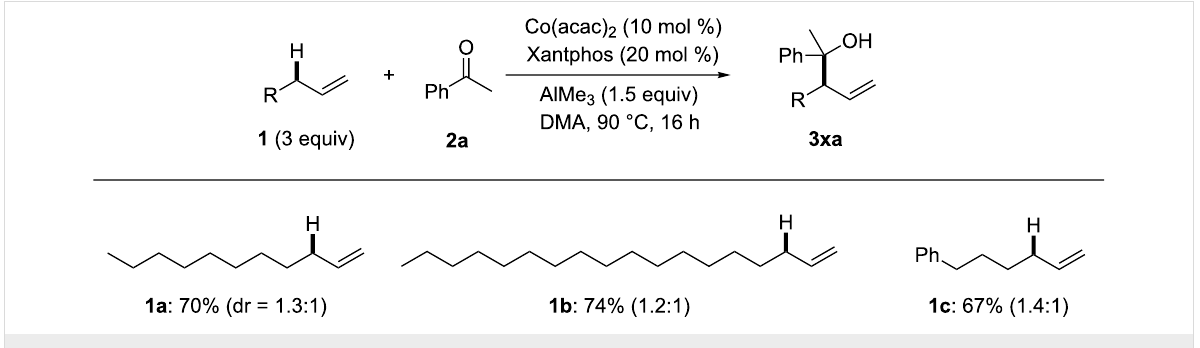
Figure 3: Substrate scope for α -olefins.